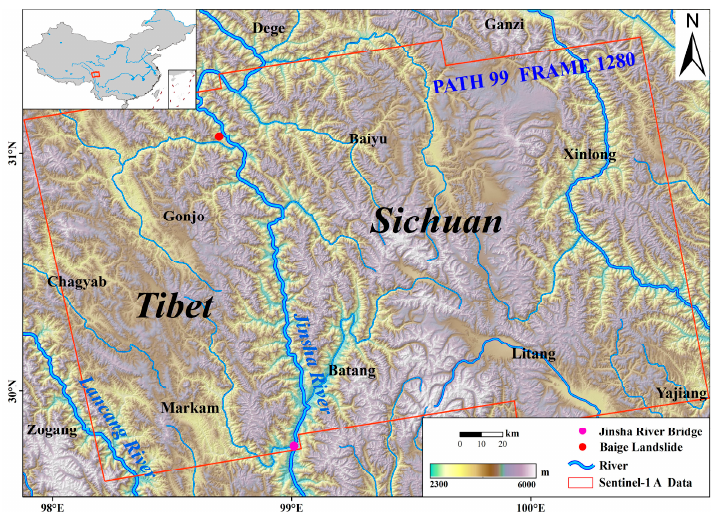
Figure 7. Study area and SAR image coverage. The red box represents the data coverage area of Sentinel-1, the red point indicates the location of the Baige landslide, the pink point indicates the location of the Jinsha River Bridge, and the blue lines represent the river distribution in the study area, with the locations of the Jinsha River, Lancang River, and Yalong River marked. The inset in the upper-left corner shows the location of the study area within China.